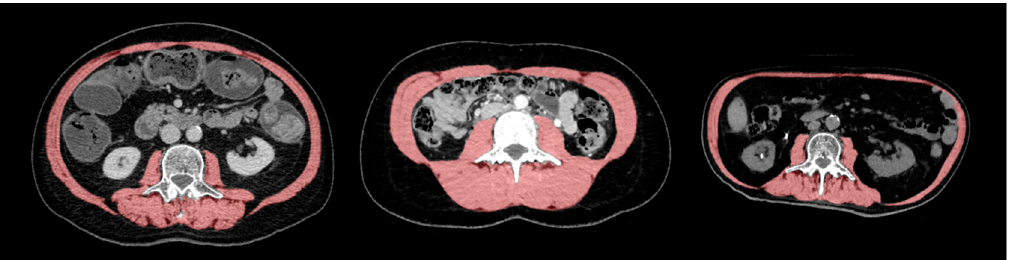
Figure 1. Skeletal muscle area morphology. Computed tomography scans show different morphotypes of skeletal muscle area (SMA) at the third lumbar vertebra (L3) level. This region contains the psoas muscle, paraspinal muscles (erector spinae, quadratus lumborum), and abdominal wall muscles (transversus abdominus, external and internal obliques, rectus